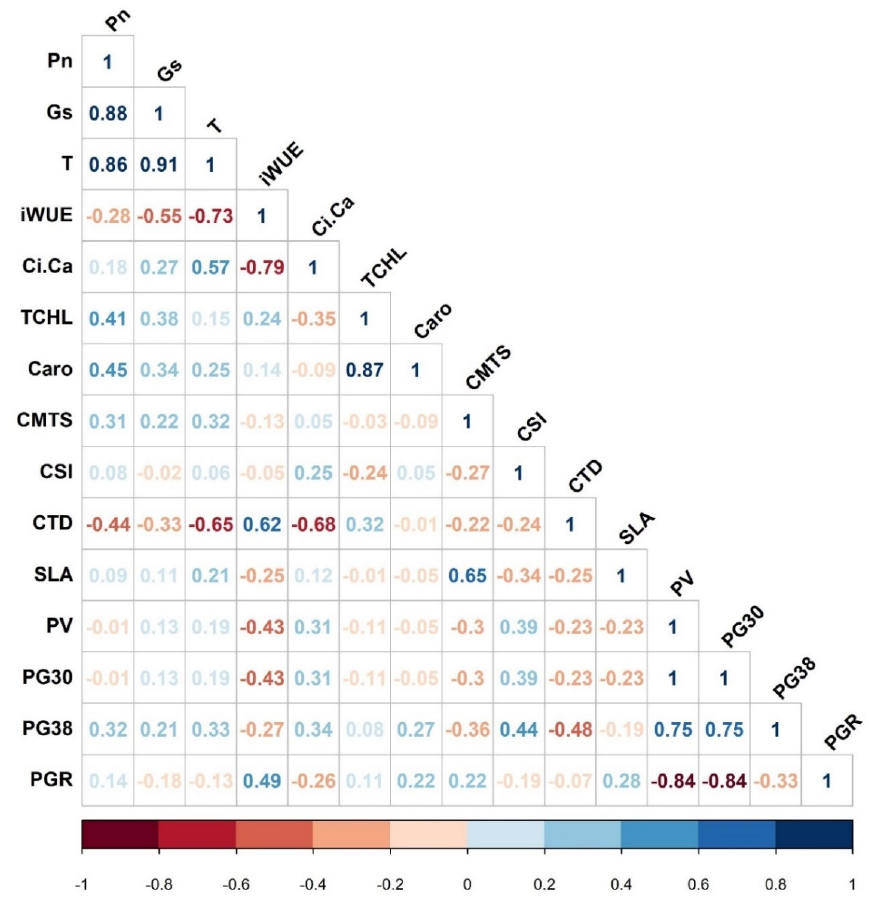
Figure 2. Cotton chromosome substitution (CS) line trait correlations of the recorded parameters. Dark color values represent strong correlations, and light color values represent weaker correlations. Values close to zero indicate no correlation between the two variables; whereas, values close to ± indicate strong correlation (positive—dark blue and negative-dark red) between two traits. Leaf gas